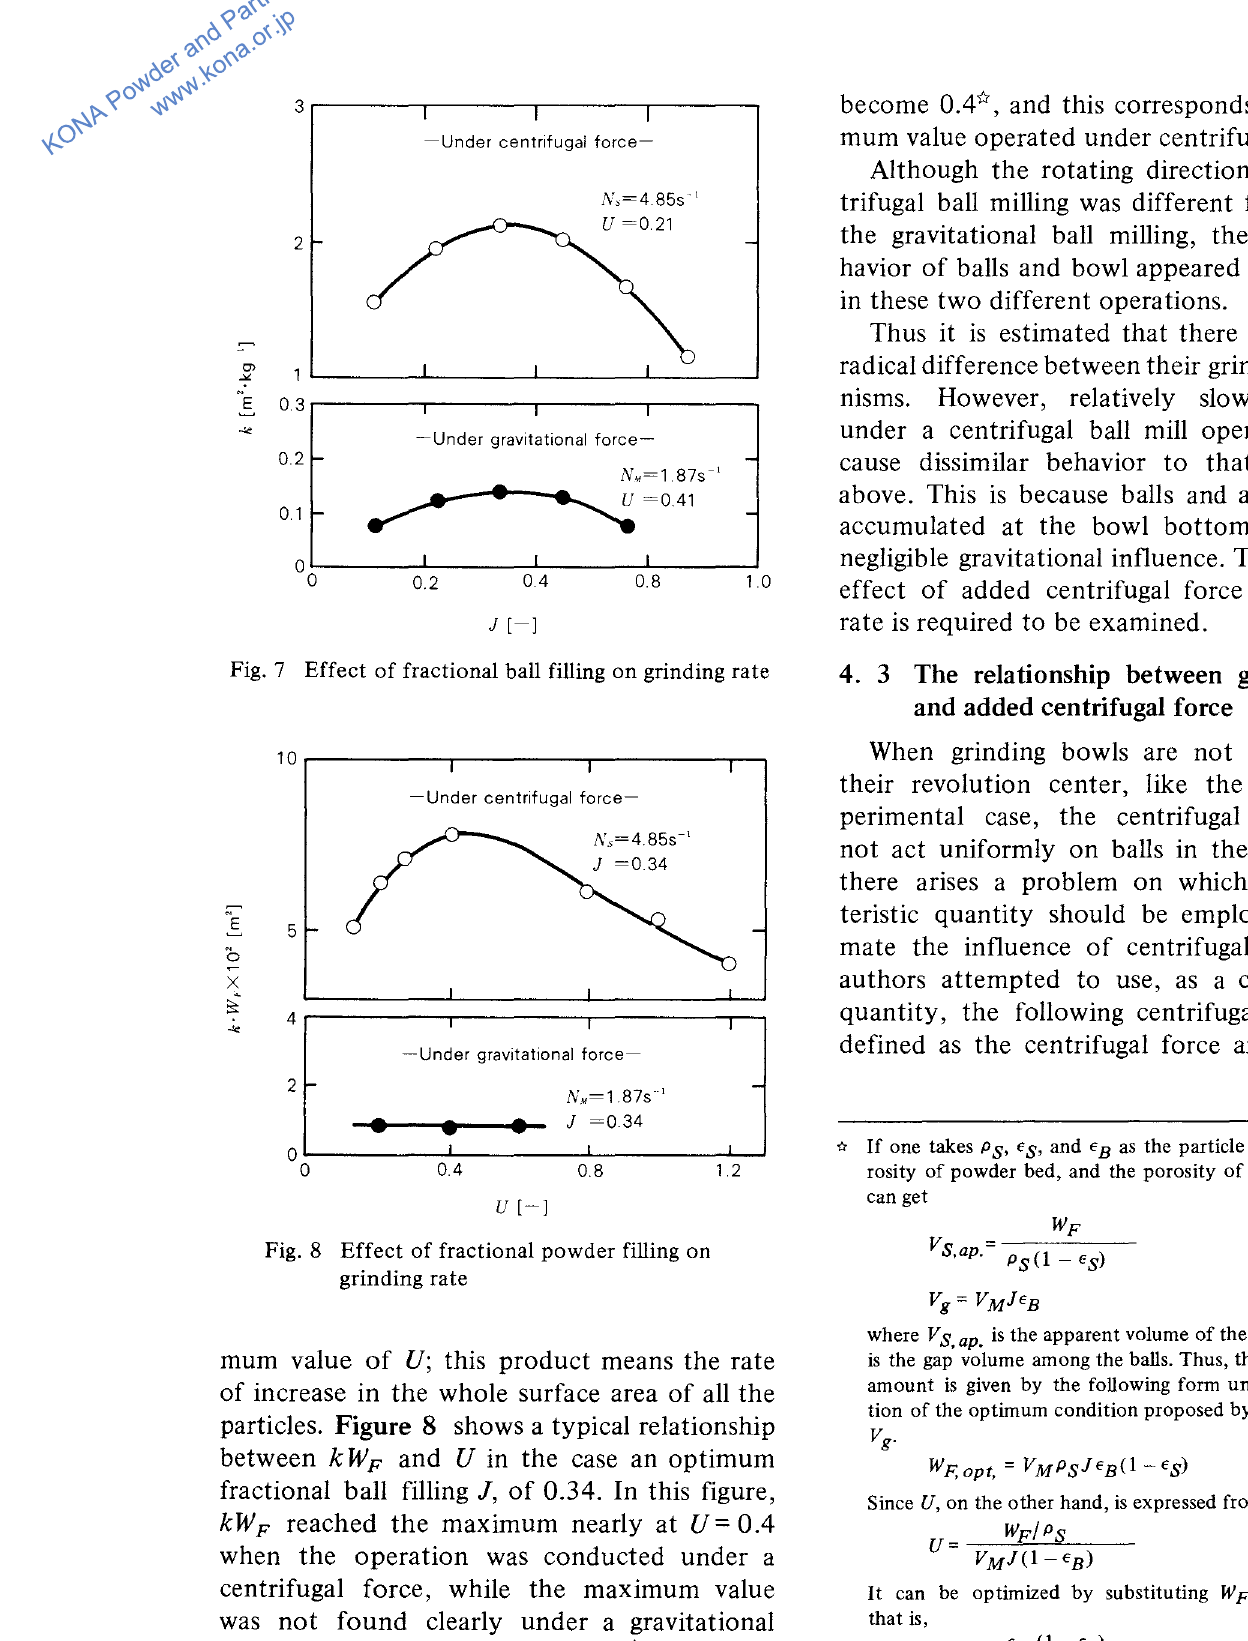
Fig. 8 Effect of fractional powder filling on grinding rate